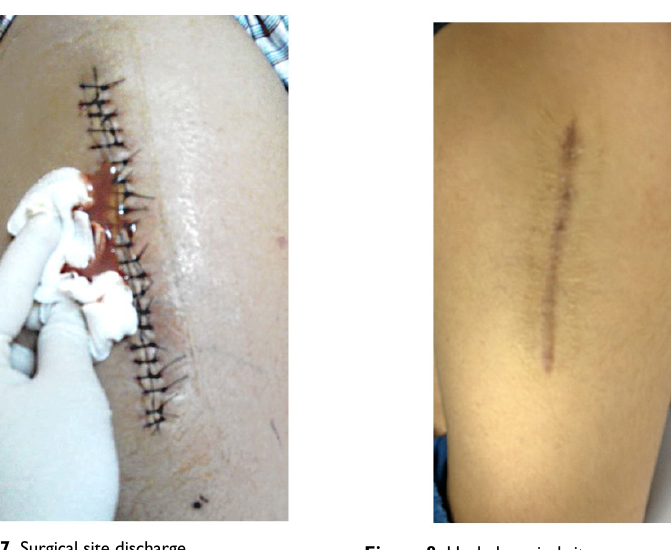
Figure 6. MRI showing osteomyelitis right femur